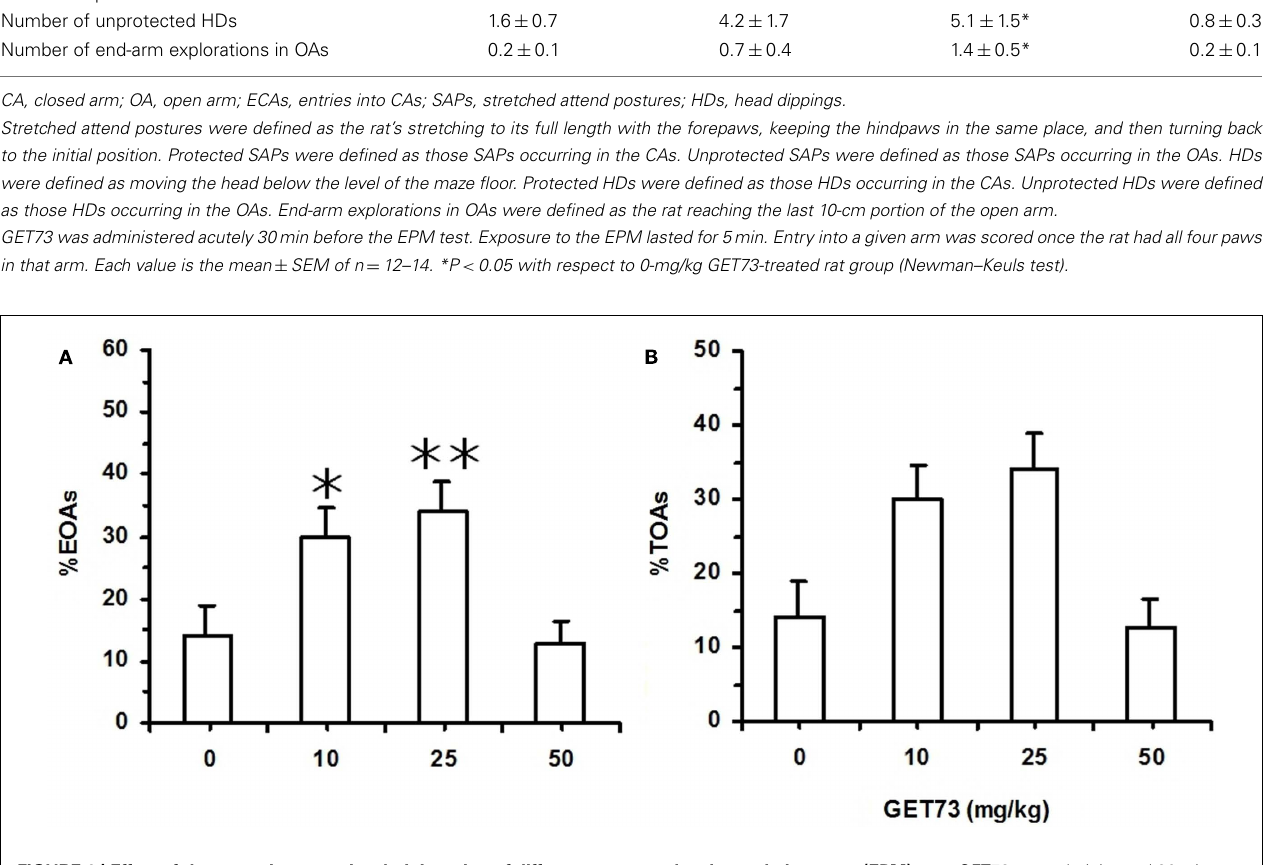
open arms (OAs; %EOAs; expressed as percent of total number of entries into arms (A))]; time spent in OAs [(%TOAs; expressed as percent of